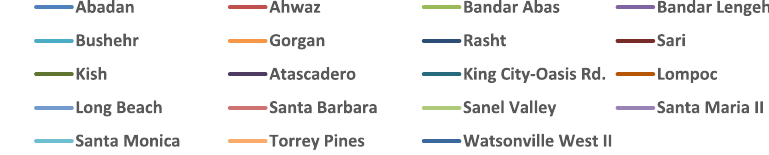
Fig. 3 Wind speed based on 365 days from various stations